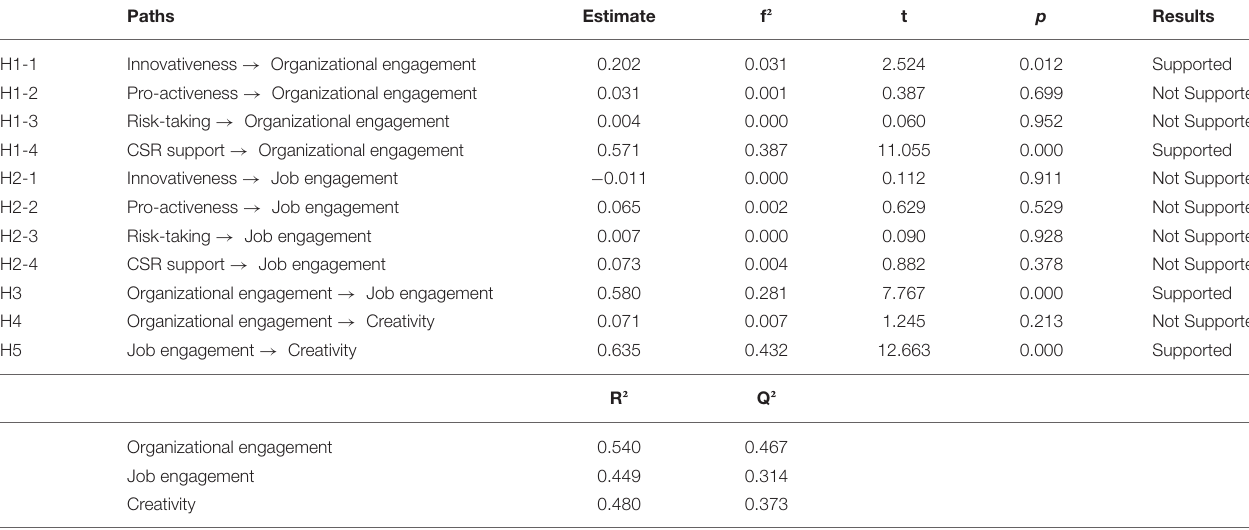
TABLE 4 | Structural estimates (PLS).